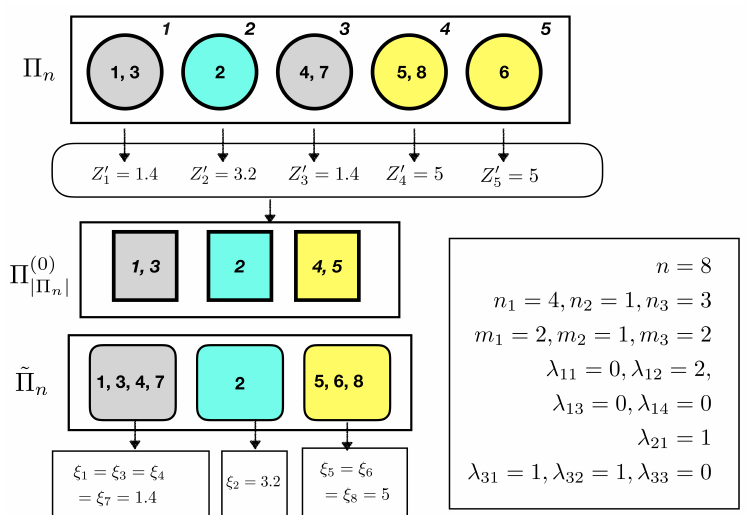
Figure 1. Pictorial representation of the latent partition structure of an mSSS. In the example, the partition induced by ( ξ 1 , . . . , ξ n ) for n = 8 is ˜ Π n = { [ 1,3,4,7 ] , [ 2 ] , [ 5,6,8 ] } , and it is represented using rounded squares (left bottom). Circles at the top left represent a compatible latent partition, namely Π n = { [ 1,3 ] , [ 2 ] , [ 4,7 ] , [ 5,8 ] , [ 6 ] } . The partition on { 1, . . . ,5 } induced by the latent Z (cid:48) n , i.e., Π ( 0 ) = { [ 1,3 ] , [ 2 ] , [ 4,5 ] } , is represented with squares in the middle of the figure. Combining Π n and | Π n | Π ( 0 ) , one obtains ˜ Π n . The statistics n , m and λ corresponding to this particular configuration are | Π n | shown in the box at the bottom